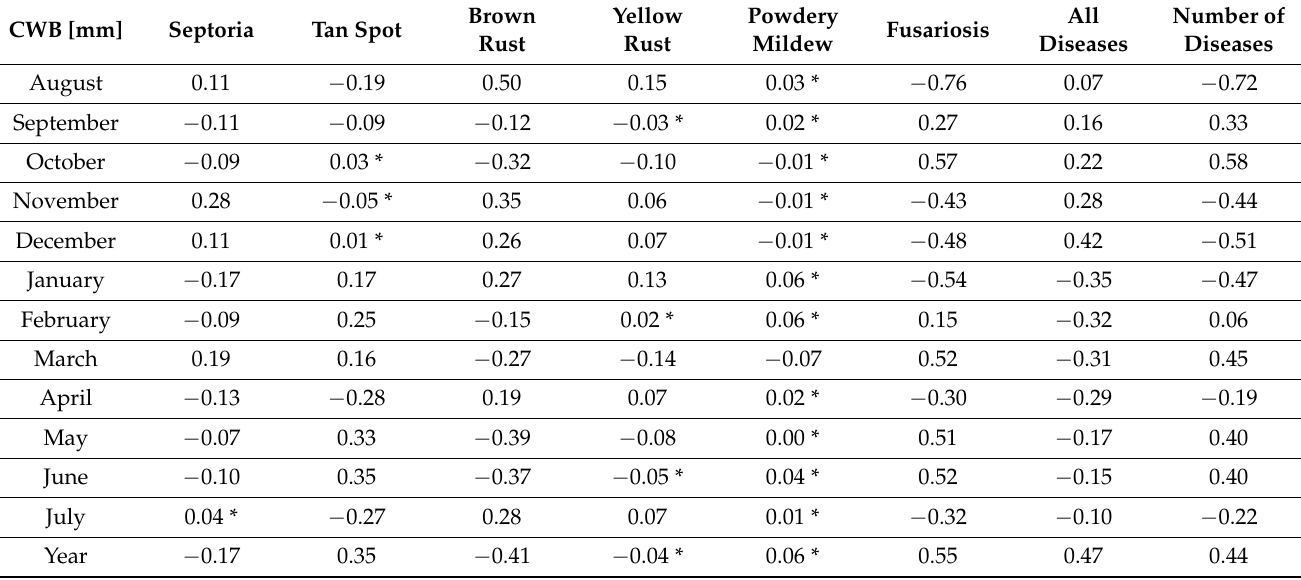
Table 7. Pearson’s linear correlation between climatic water balance (CWB [mm]) and wheat foliar disease